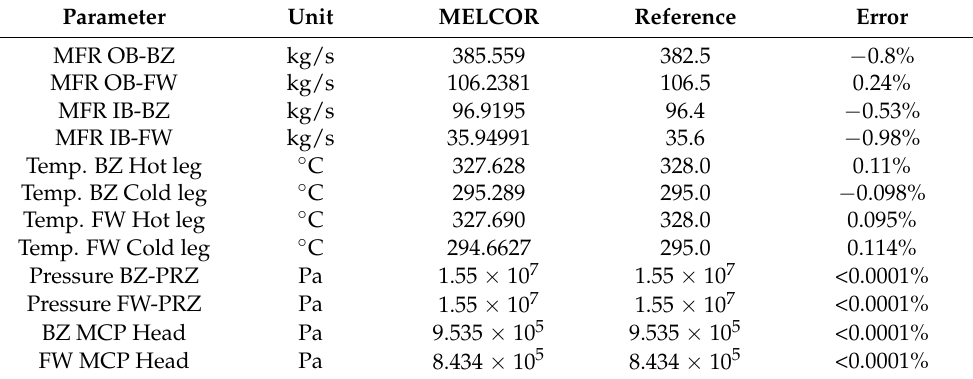
Table 1. FW and BZ parameters at steady-state.